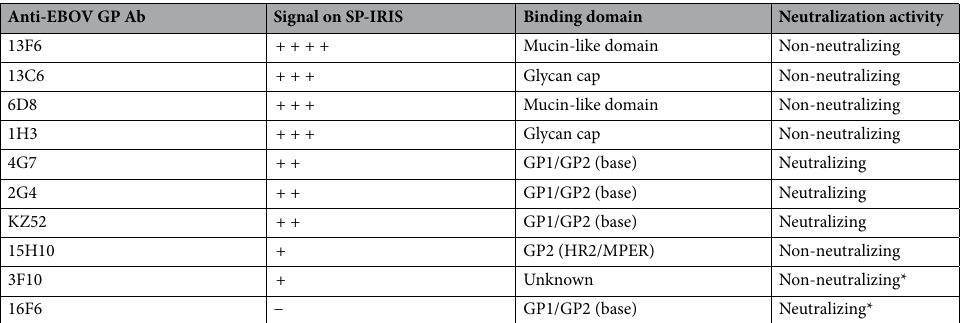
Table 1. mAbs against EBOV GP, their relative signal on SP-IRIS, binding domains on the GP, and neutralization activities. The degree of binding is denoted by + /- symbols: + + + + very high, + + + high, + + medium, + little, − no binding. *Neutralization tests for 3F10 and 16F6 were performed by